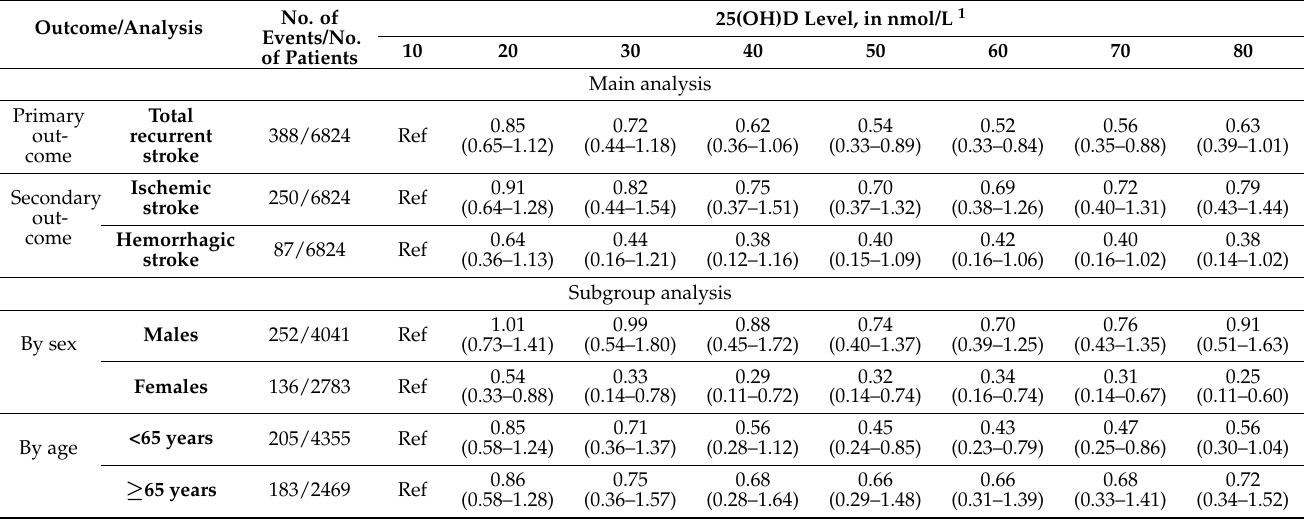
Figure 1. Restricted cubic spline showing the 25(OH)D levels in relation to risk of recurrent stroke (shadow indicating the 95% confidence intervals). Table 2. Results for the relationship between serum 25(OH)D level and recurrent stroke risk.